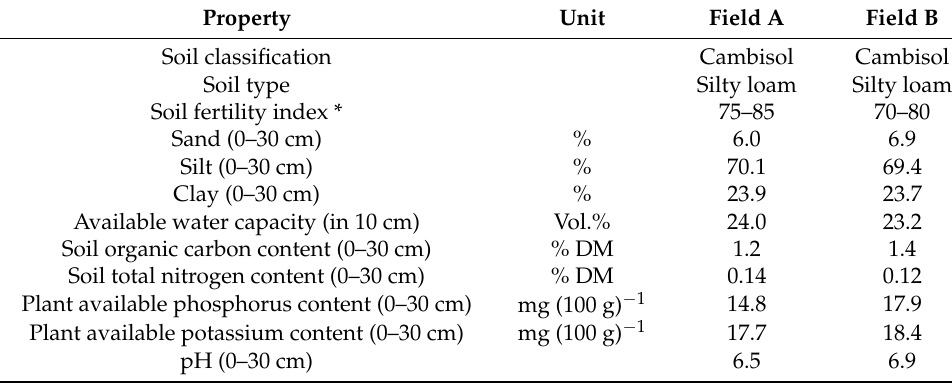
Table 1. Soil data—Makofen Research Farm.